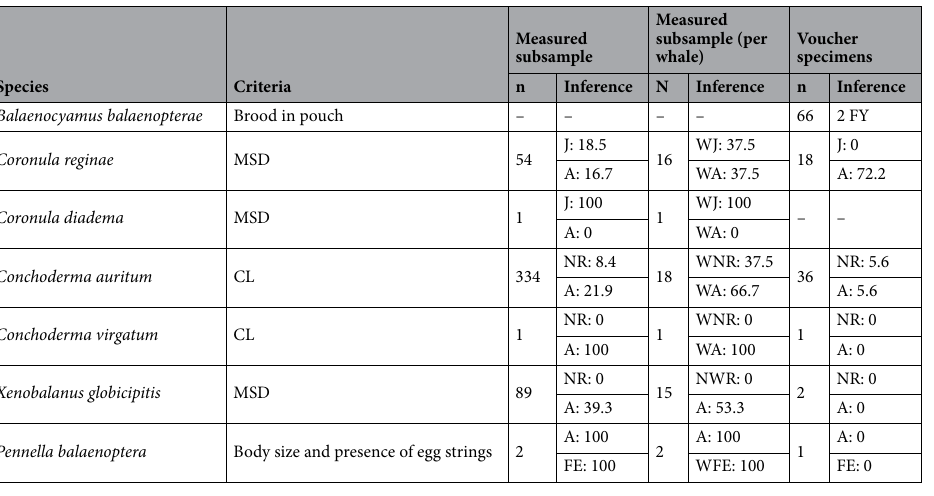
Table 5. Inferences of recruitment, age classes and reproductive status of the epibiotic fauna found on Antarctic minke whales, Balaenoptera bonaerensis , in the Southern Ocean. Inferences were drawn from a subsample of n measured epibionts, from the measured epibionts of each whale ( N whales), and from additional voucher specimens deposited at the Institute for Whale Research of Japan. (see also Table 1): A Percent adults, CL Capitulum Length, FE Percent females with egg strings, FY No. females with young in marsupium, J Percent juveniles, MSD Maximum Shell Diameter, NR Percent newly recruited individuals, WA Percent whales harboring adults, WFE Percent whales harboring females with egg strings, WJ Percent whales harboring juveniles, WNR Percent whales harboring newly recruited individuals. See text for measurement